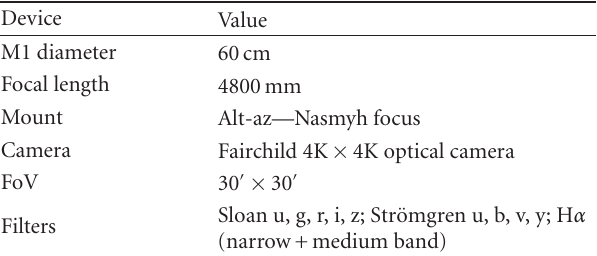
Table 1: TROBAR main features.